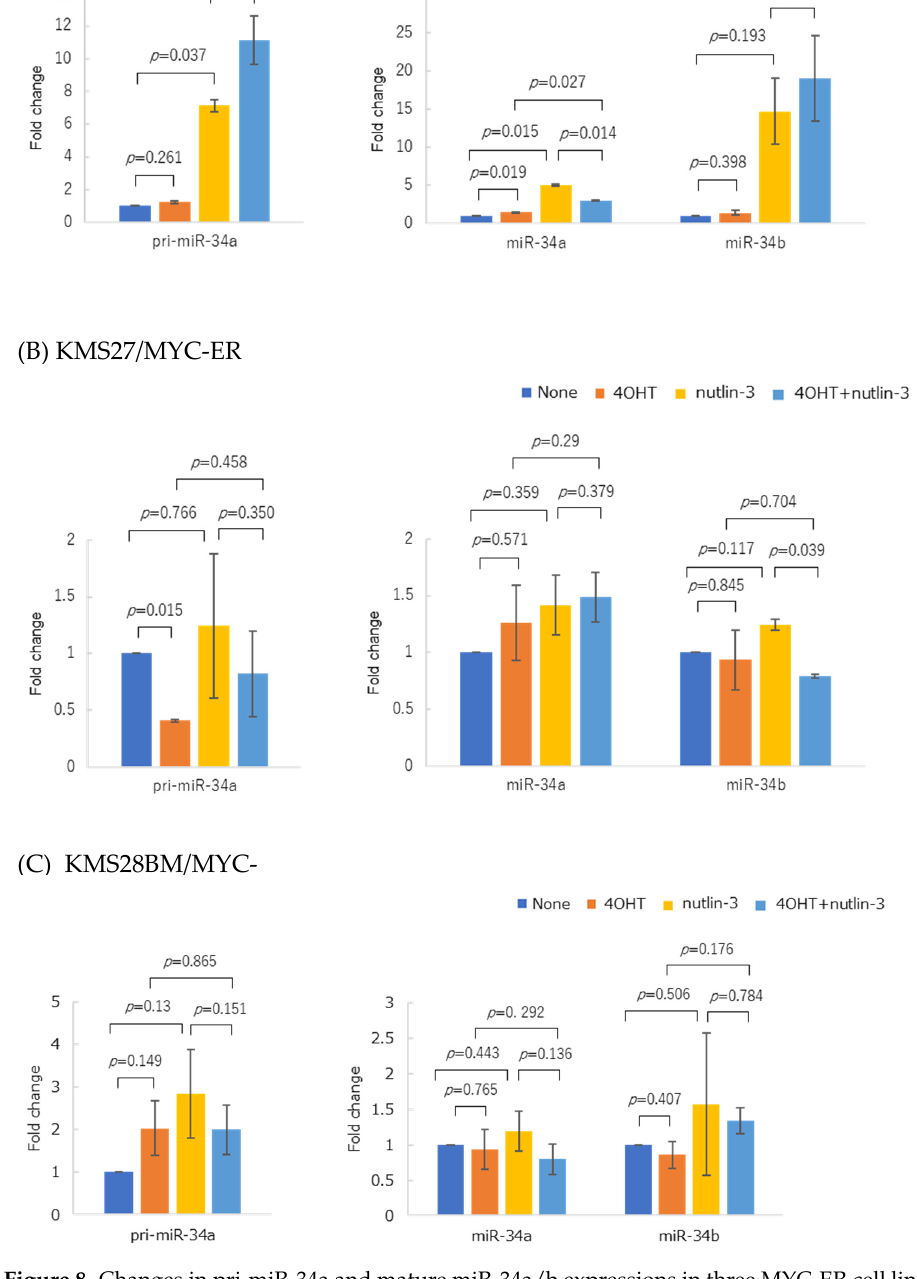
Figure 8. Changes in pri-miR-34a and mature miR-34a/b expressions in three MYC-ER cell lines after 4OHT tamoxifen and nutlin-3 treatment. ( A ) U2OS treated for 96 h with 1 µ M 4OHT tamoxifen and 1 µ M nutlin-3. ( B ) KMS27 treated for 6 h with 1 µ M 4OHT tamoxifen and for 72 h with 10 µ M nutlin-3. ( C ) KMS28BM treated for 72 h with 1 µ M 4OHT tamoxifen and 10 µ M nutlin-3. Only experiments with KMS28BM were performed in triplicate. Other experiments were performed twice. Error bars show the standard deviation (SD) across the experiments. Blue, no treatment; orange, with 1 µ M 4OHT tamoxifen; yellow, with 1 or 10 µ M nutlin-3; light blue, with co-treatment of 4OHT tamoxifen and nutlin-3.